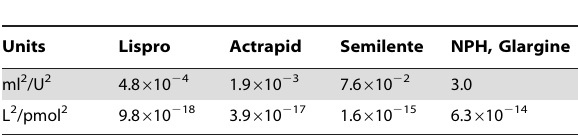
Figure 3. Numerical simulations of insulin hexamer, dimer and monomer concentration kinetics in a model human islet at multiple glucose concentrations. Profiles show the dynamics of the concentrations of newly synthesized insulin (in hexamer H , dimer D , monomer M ) and returned peripheral insulin I and the equilibrium ( H (cid:2) , D (cid:2) , M (cid:2) , I (cid:2) ) (pM) at different clamped glucose inputs G 0